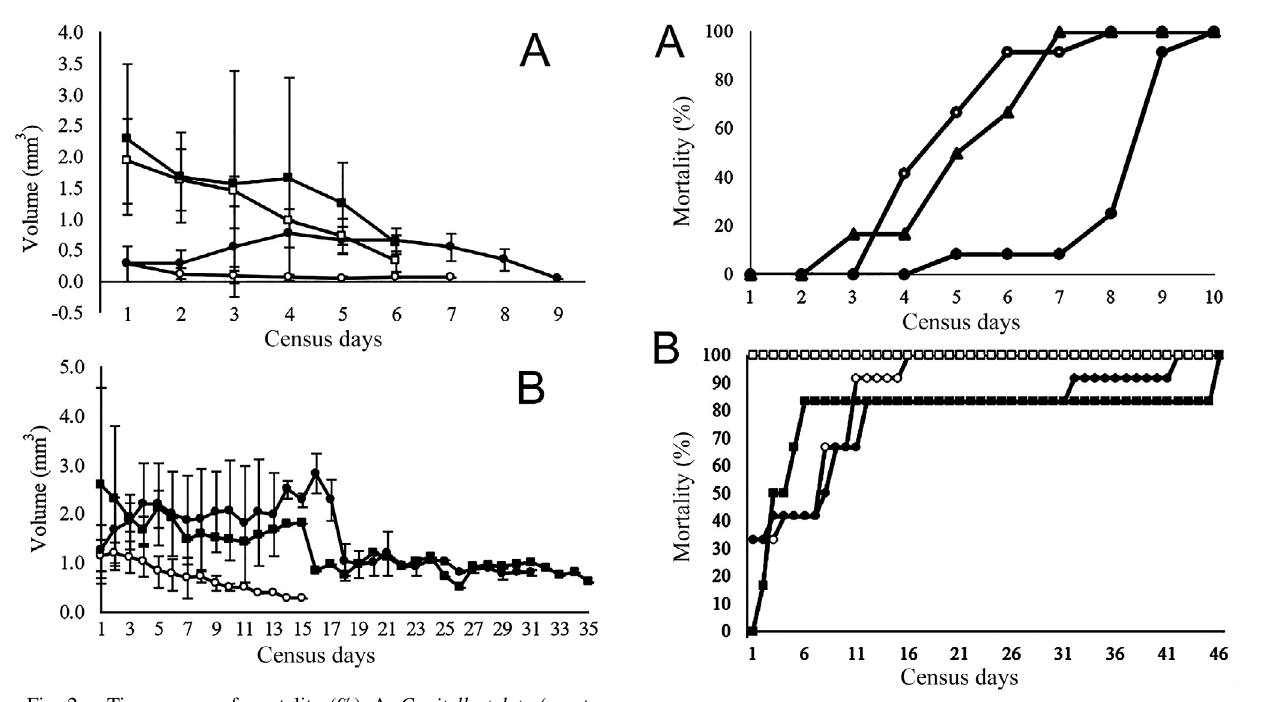
Fig. 3. – Time course of average body volume ±sd. A, Capitella teleta ; B, Capitella sp. (empty circles, juveniles in NOES; full circles, juveniles in OES; empty squares, adults in NOES; full squares, adults in OES). 4. – Initial and final body volumes until death of adults, development of sexual structures (worm volumes between brackets) and days of appearance (GS, genital spines; YO, yellow ovaries; WO, white ovaries; * no more pictures taken because the worm was New sexual structures